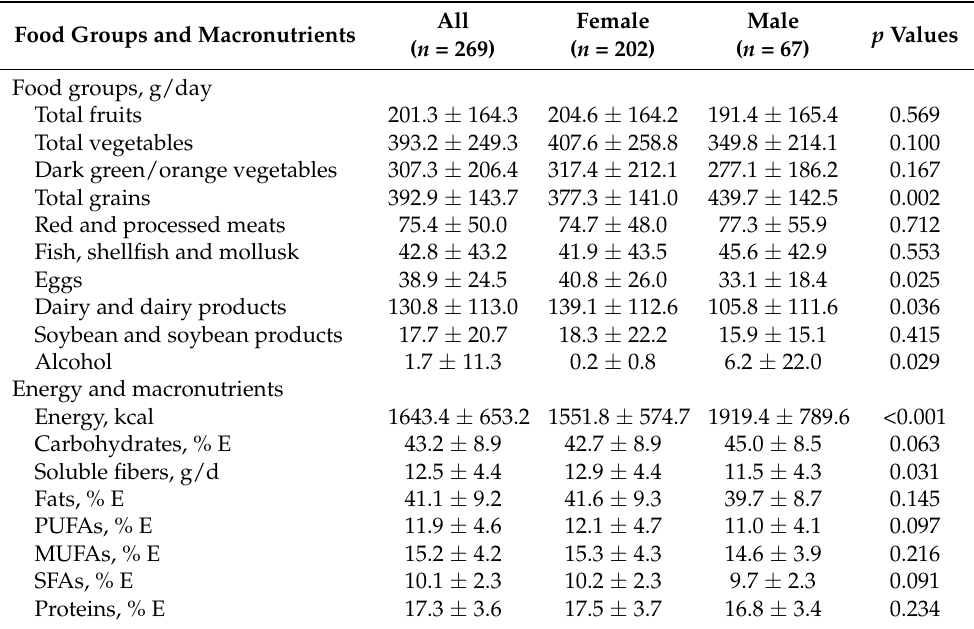
Table 3. Daily dietary and macronutrient intake of 269 Chinese participants with hyperlipidemia according to gender 1,2